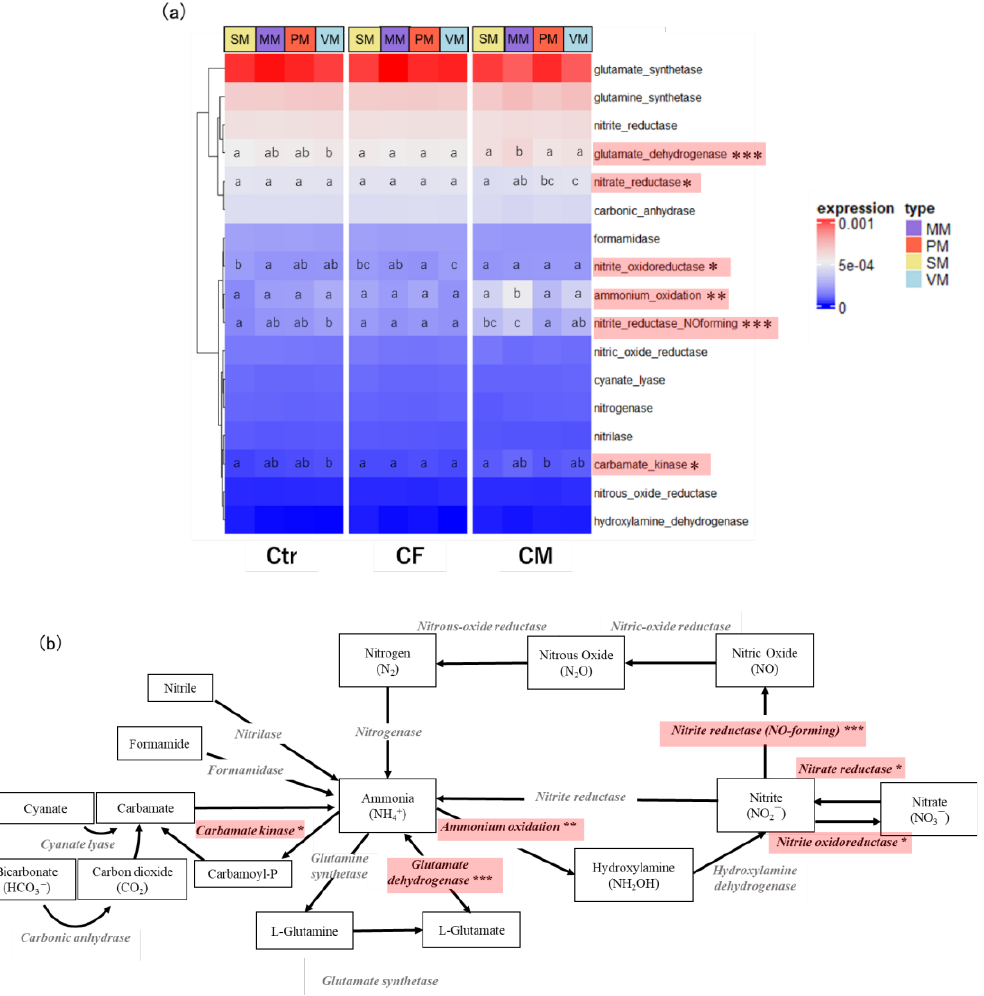
Figure 4. ( a ) Predicted prokaryotic genes coding N metabolism pathway from KEGG database. Asterisk show P value of two-way ANOVA interaction for legume and fertilizer treatments (* p < 0.05, ** p < 0.01, and *** p < 0.001). Different letters in the table indicate significant ( p < 0.05) pairwise dif- ferences among legume treatments. Individual KEGG codes are described in Table S1. ( b ) N metab- olism pathway (ko00910) and enzymes based on Kyoto Encyclopedia. The genes highlighted in red indicate significant pathways for the two-way ANOVA interaction.